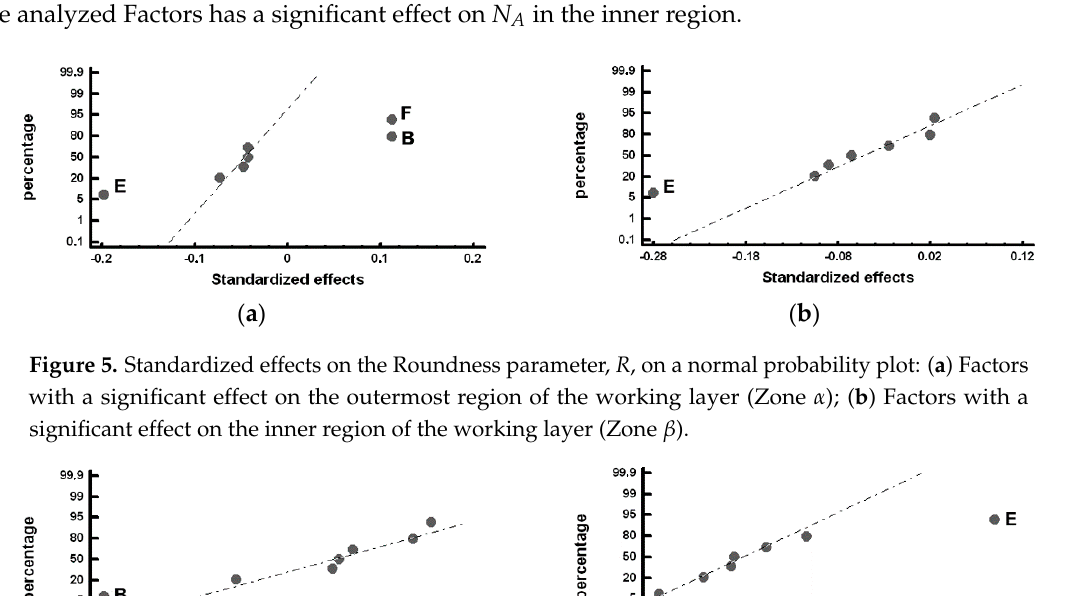
Figure 5. Standardized effects on the Roundness parameter, R , on a normal probability plot: ( a ) Factors with a significant effect on the outermost region of the working layer (Zone α ); ( b ) Factors with a significant effect on the inner region of the working layer (Zone β ).